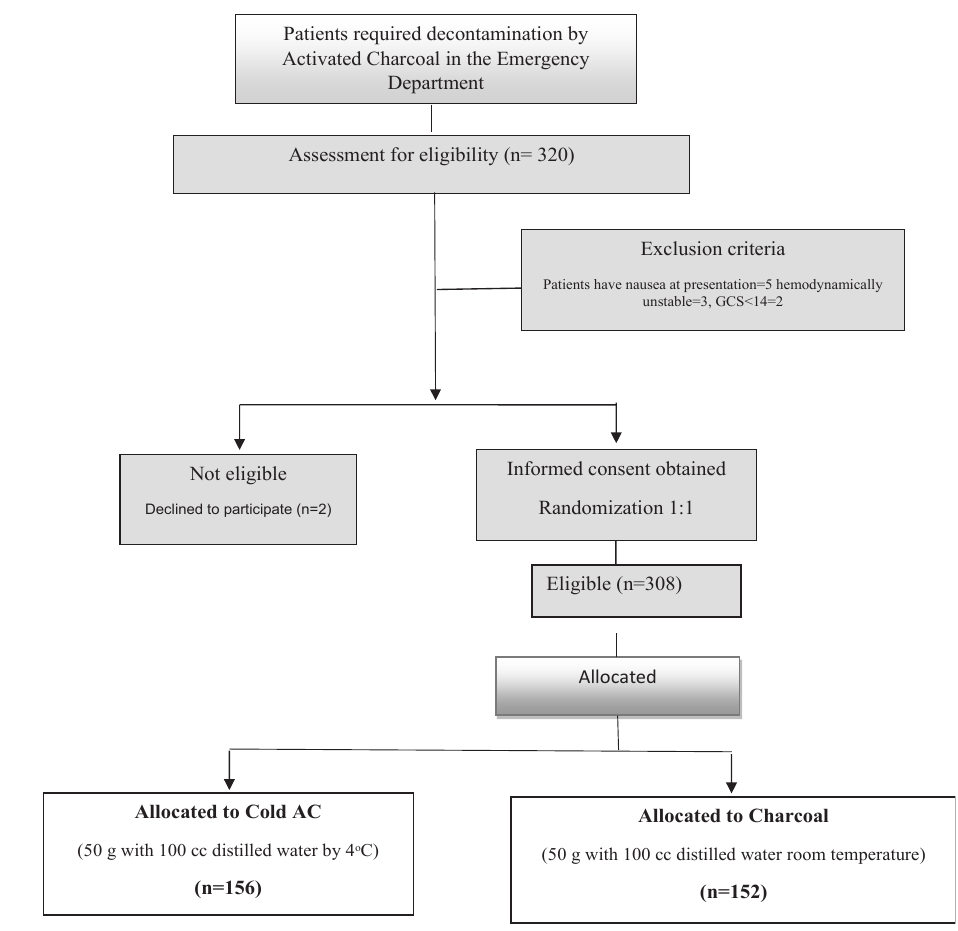
Figure 1. Study Protocol.